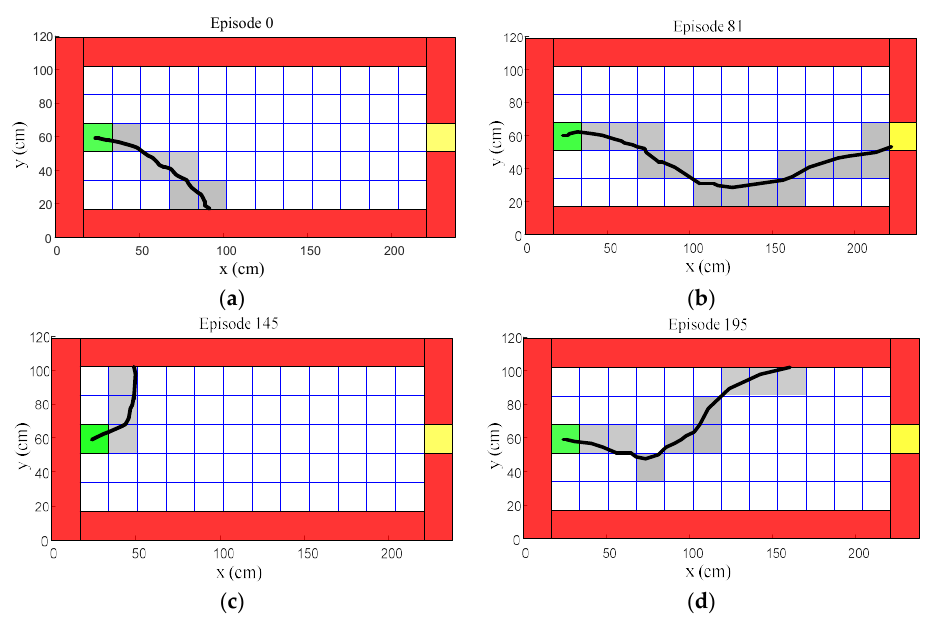
Figure 21. Results in the initial stage of the learning process: ( a ) episode 0; ( b ) episode 81; ( c ) episode 145; ( d ) episode 195.